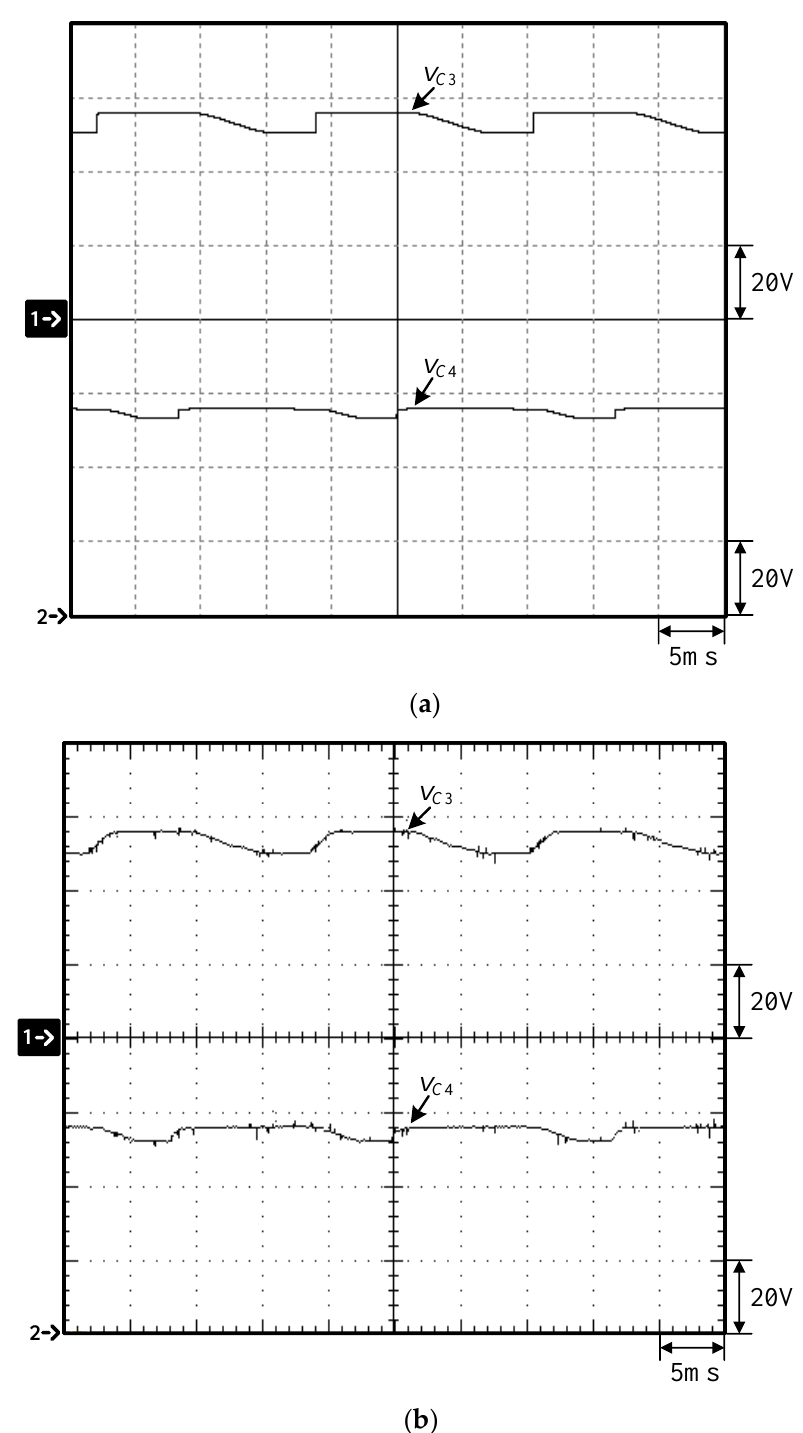
Figure 17. Waveforms at rated load with (1) v C 1 and (2) v C 2 : ( a ) simulated; ( b ) measured.